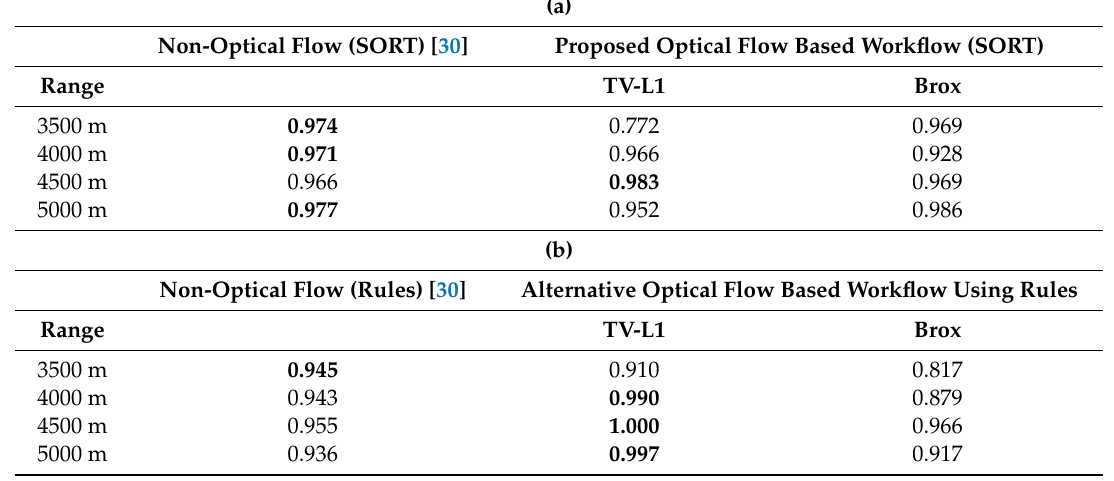
Table 3. Comparison of F1 values using di ff erent methods. ( a ) Comparison of F1 values using methods with and without optical flow. SORT was used for object association. Bold numbers indicate the best performing methods; ( b ) Comparison of F1 values using methods with and without optical flow. Rules were used for object association between frames. Bold numbers indicate the best performing methods.